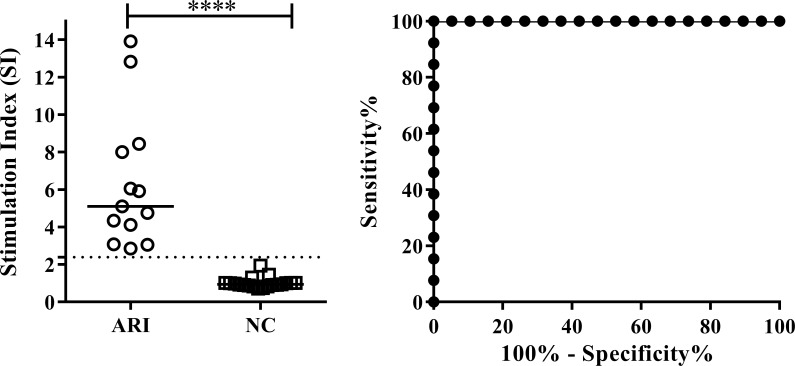
Lymphoproliferative response of HIV+ subjects living in the VL endemic area of Fuenlabrada following stimulation of their PBMC with SLA.A) Response to SLA by asymptomatic immune responders (ARI; n = 13), and non-responders (NC; n = 19). B) Area under the receiver operating characteristic curve. ****p<0.0001.